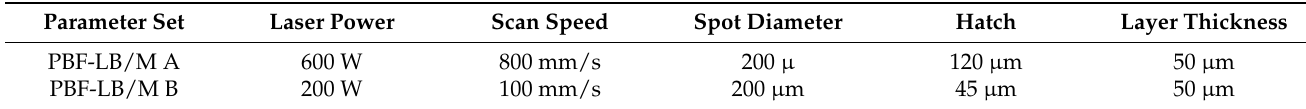
Table 2. PBF-LB/M parameter sets used in this work.